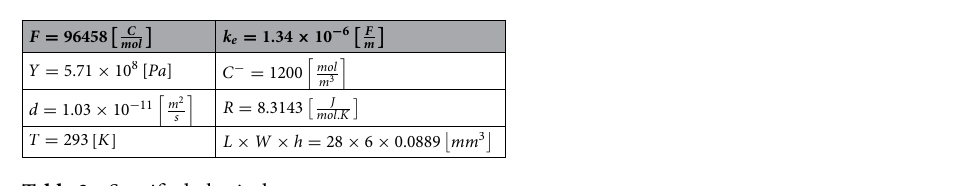
Table 2. Specified physical parameters.